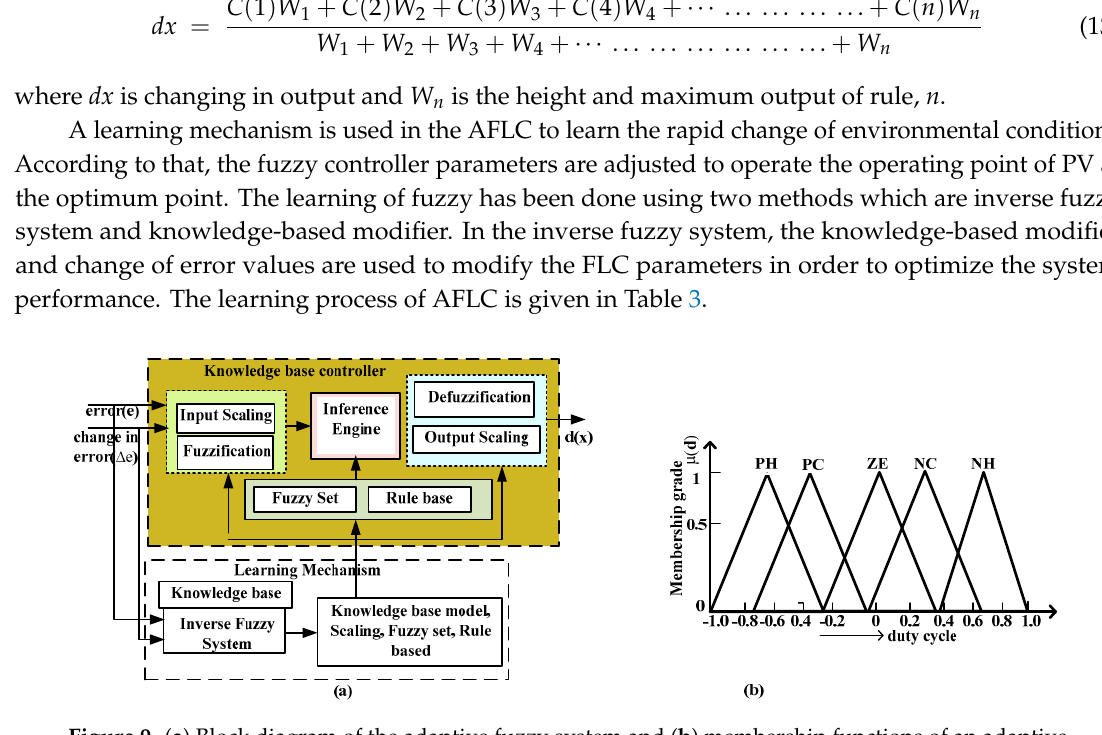
Figure 9. ( a ) Block diagram of the adaptive fuzzy system and ( b ) membership functions of an adaptive fuzzy logic controller (AFLC). Table 2. Rule-based AFLC for MPPT tracking.